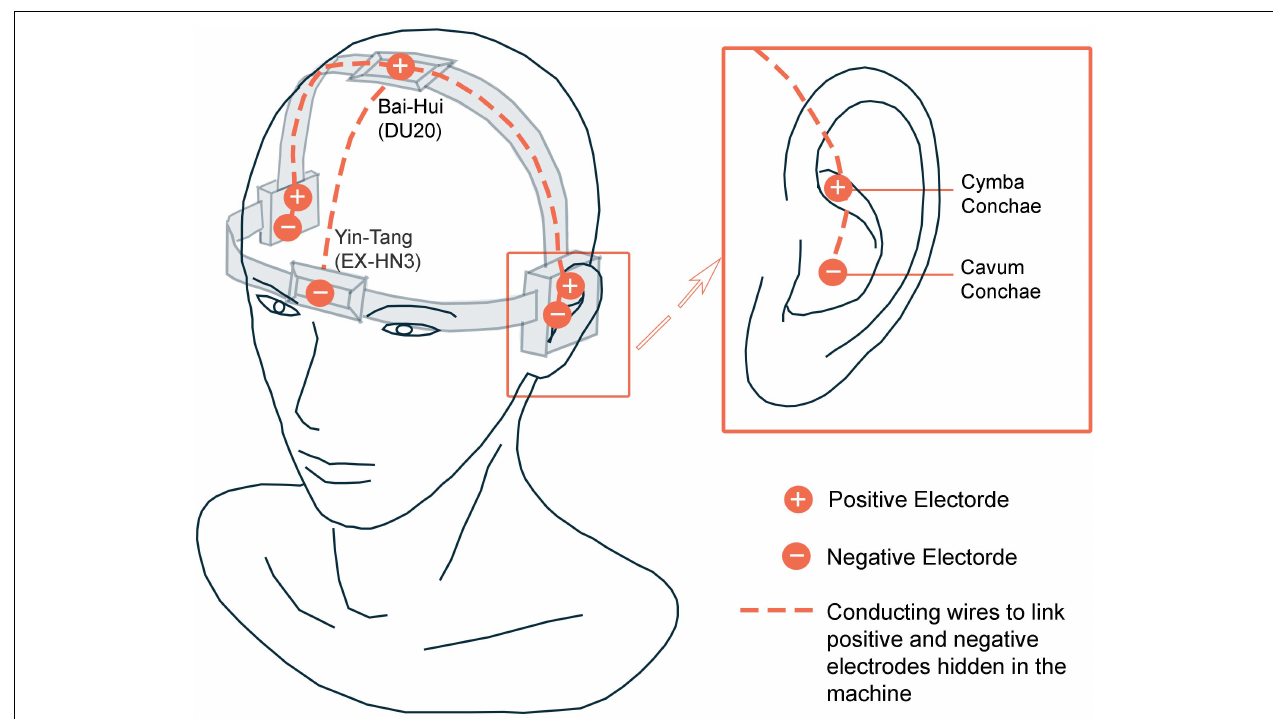
FIGURE 2 | Illustration of Transcutaneous electrical cranial-auricular acupoint stimulation